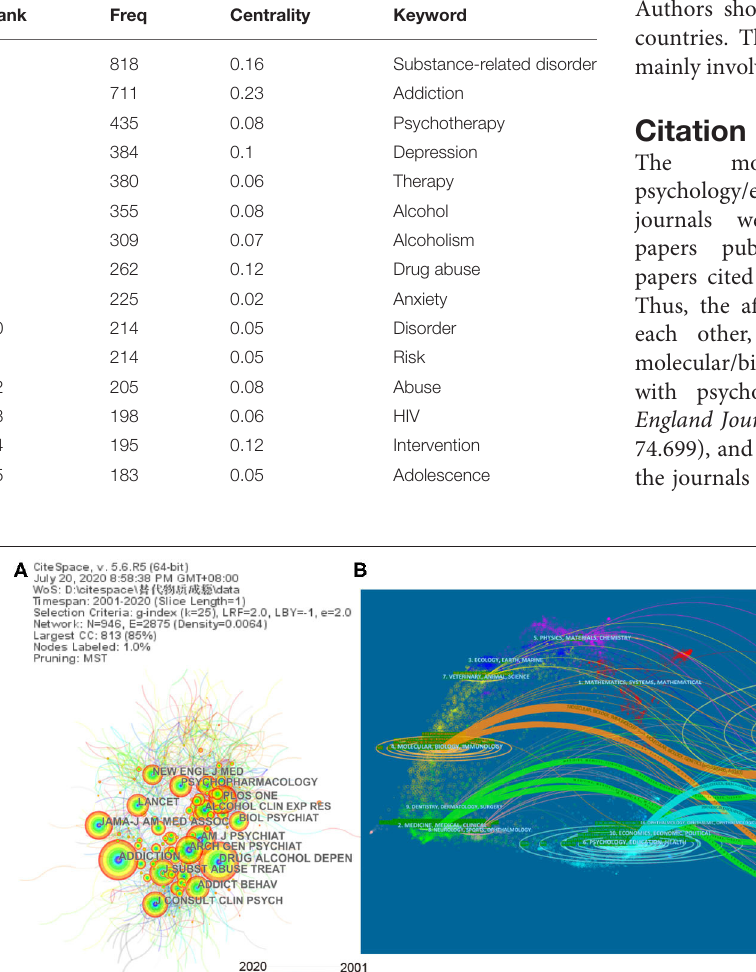
TABLE 4 | Top 15 keywords related to complementary and alternative medicine for substance use disorders.